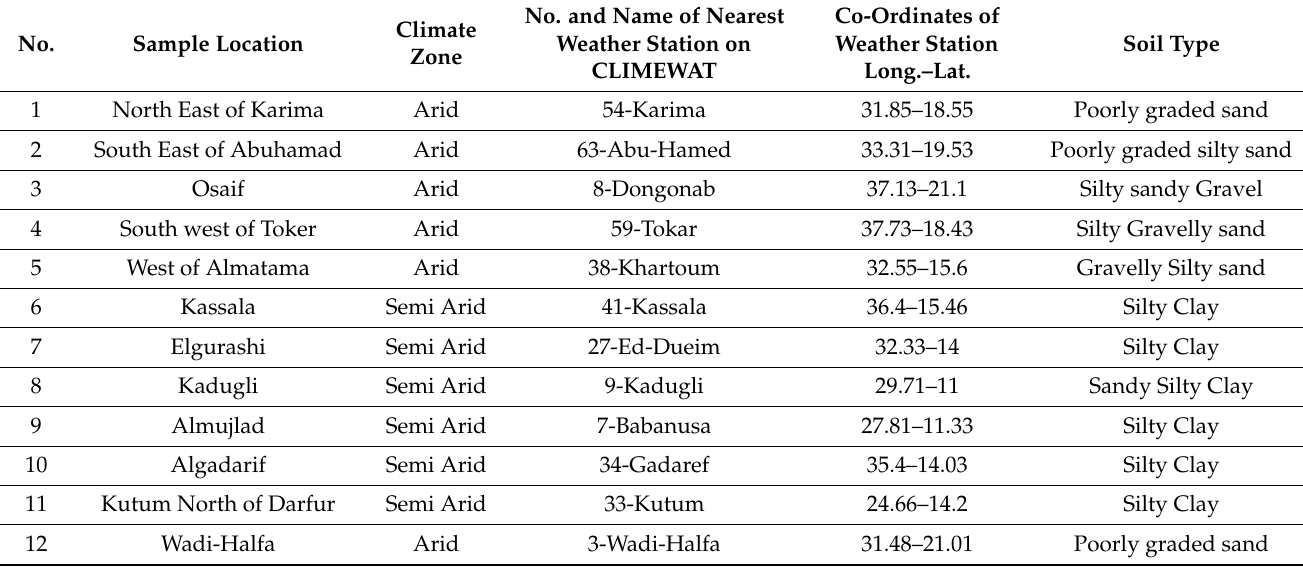
Table 1. Site locations and soil types (Adopted from